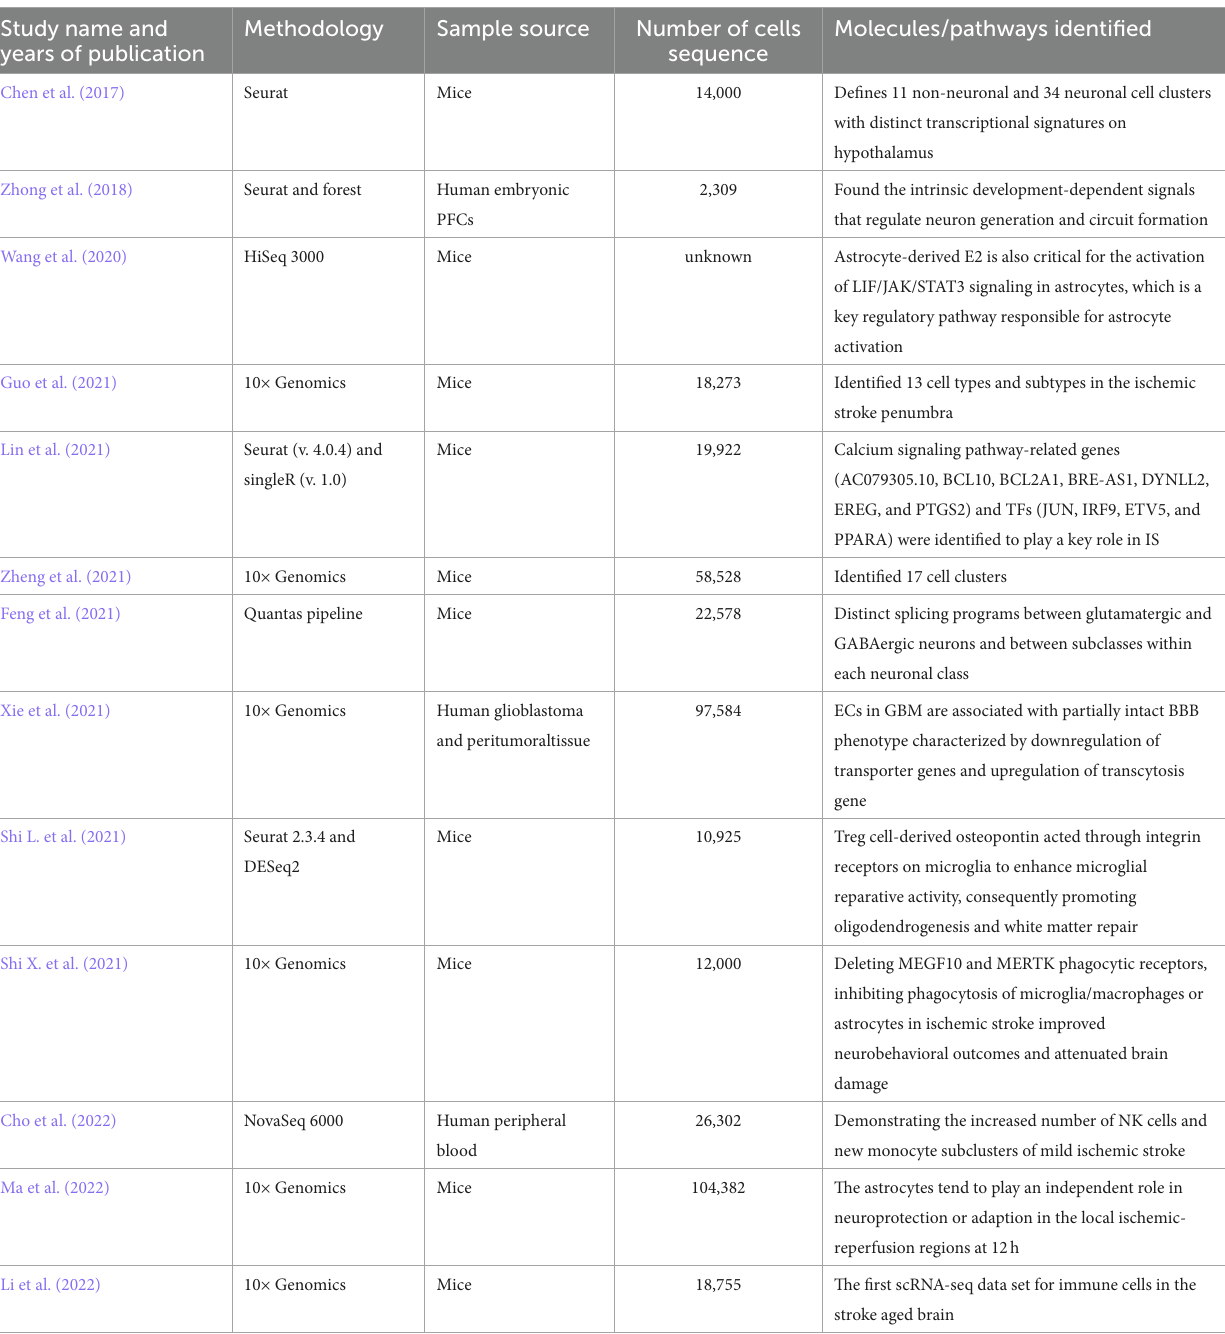
TABLE 1 Application of single cell sequencing technology in the study of ischemic